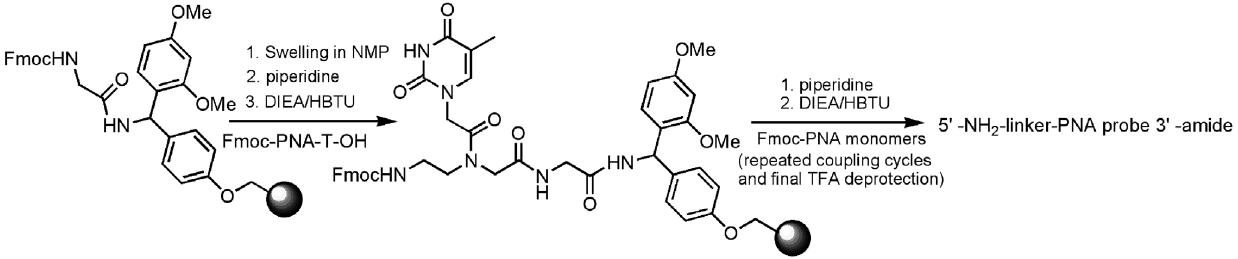
Figure 2. Automated synthetic scheme of PNA probes from 3 9 to 5 9 -amino end.